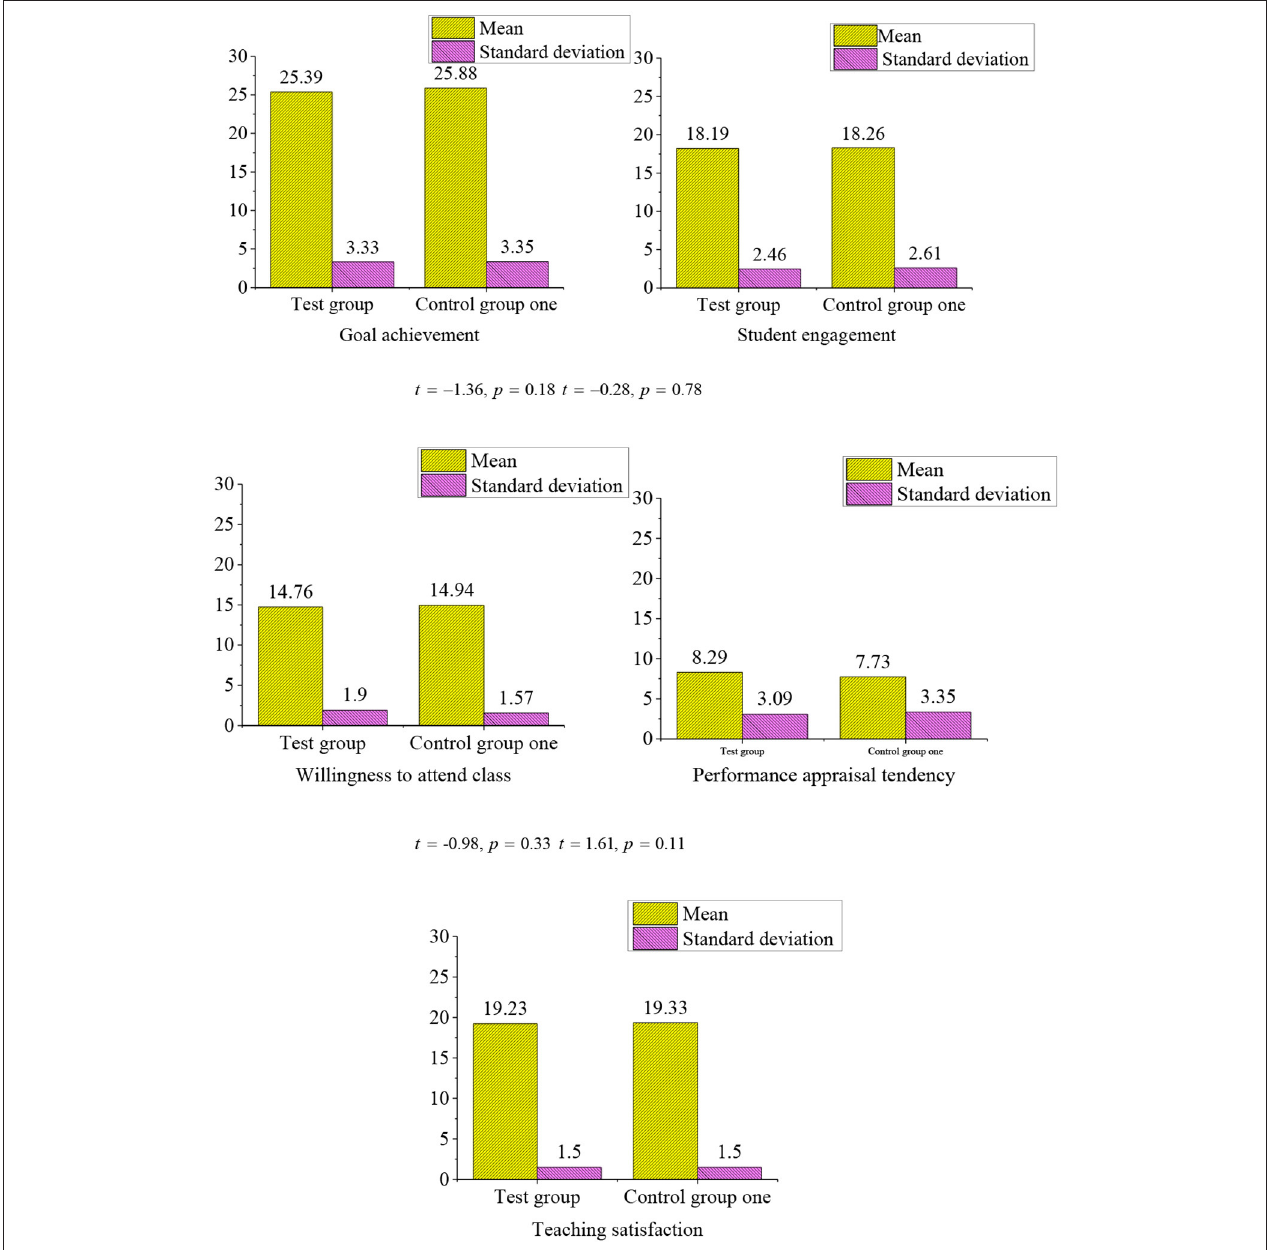
FIGURE 7 | The t -test results of the independent samples of the experimental group and control group 1 (experimental group, n = 182, control group 1, nl =